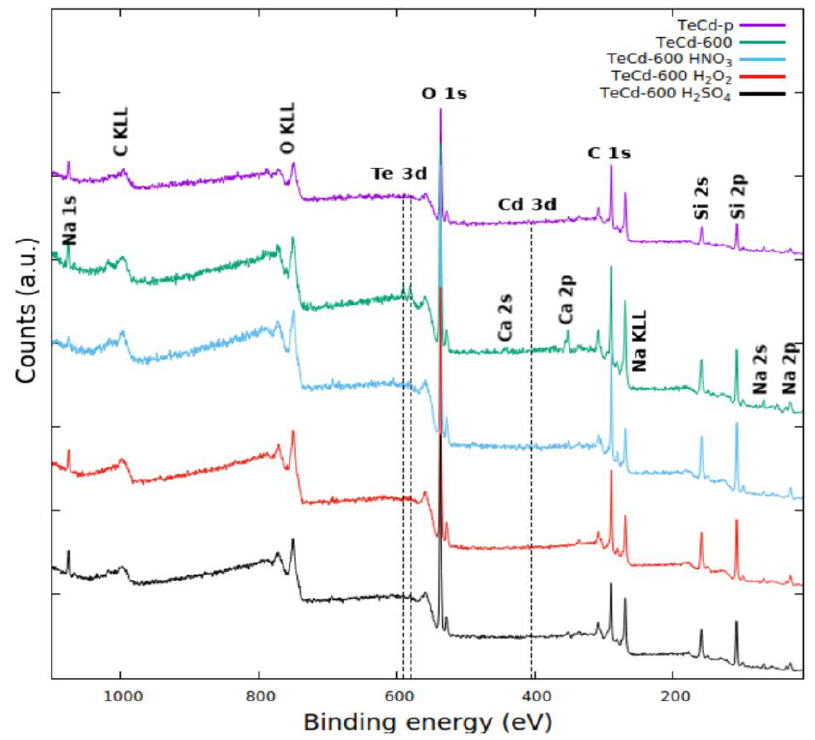
Figure 3. XPS survey-scan spectrum of samples before (TeCd-p) and after thermal treatment